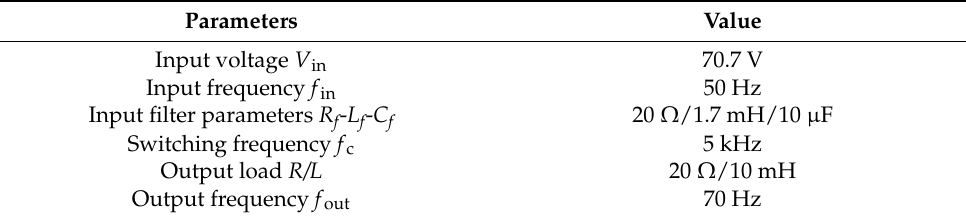
Figure 17. Laboratory prototype of the IMC. Table 5. Experimental parameters.